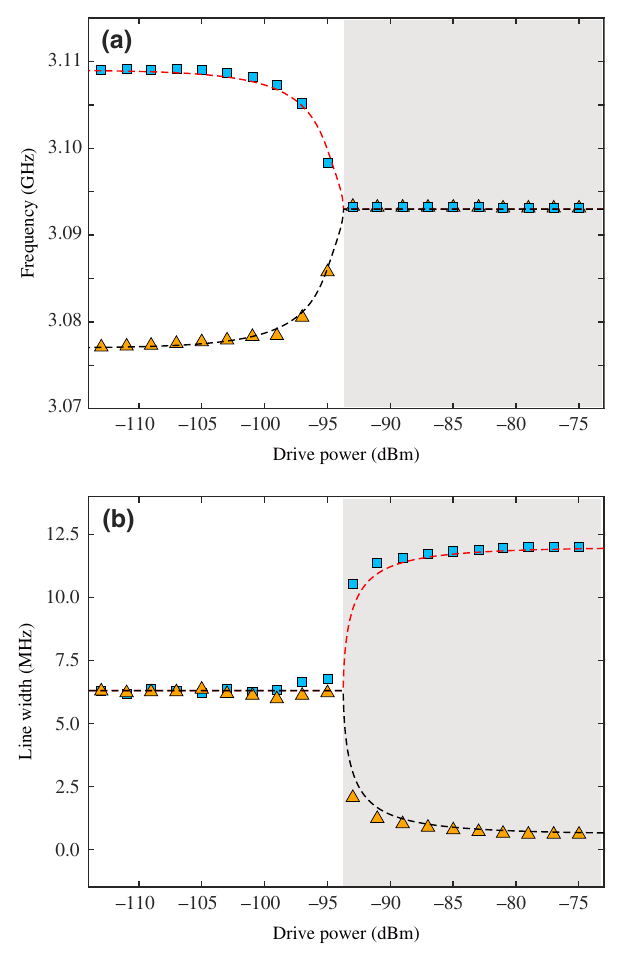
FIG. 3. The peak positions and line widths of the two polariton modes. (a) The data shown by squares and triangles are the peak positions of the two polariton modes extracted from Fig. 2(b) and the solid curves are the real parts of the two eigenvalues calcu- lated using Eq. (5). (b) The data denoted by squares and triangles are the line widths of the two polariton modes extracted from Fig. 2(b) and the solid curves are the imaginary parts of the two eigenvalues calculated using Eq. (5). When P d > 93.7 dBm, only one peak is measured. We use both Eqs. (1) and (5) to deduce the line widths of the two modes in this